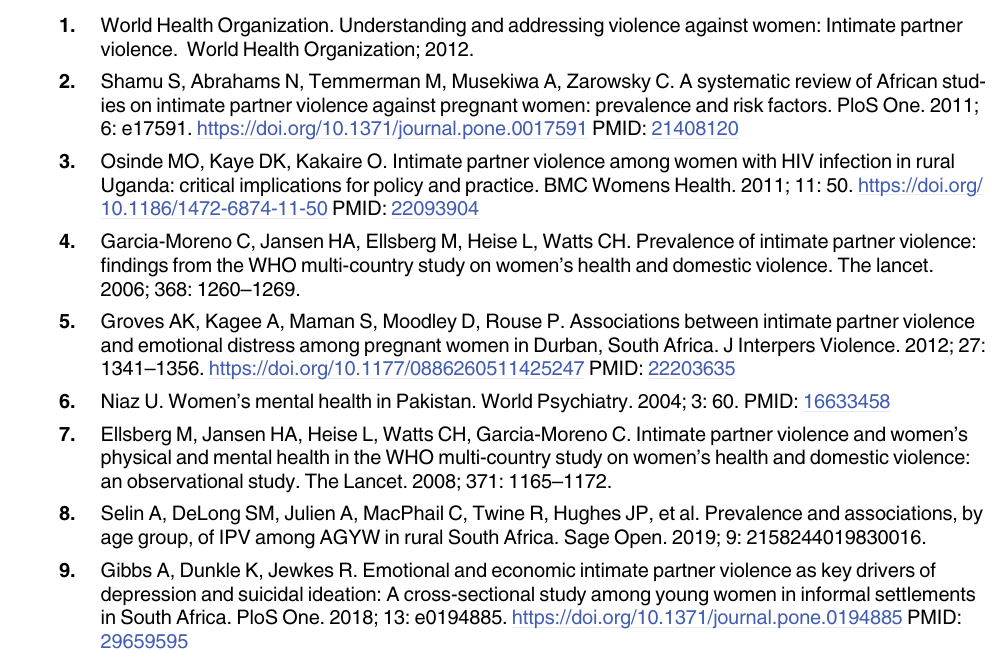
S7 Table. Pearson Chi-square test of IPEV by selected characteristics of urban women in